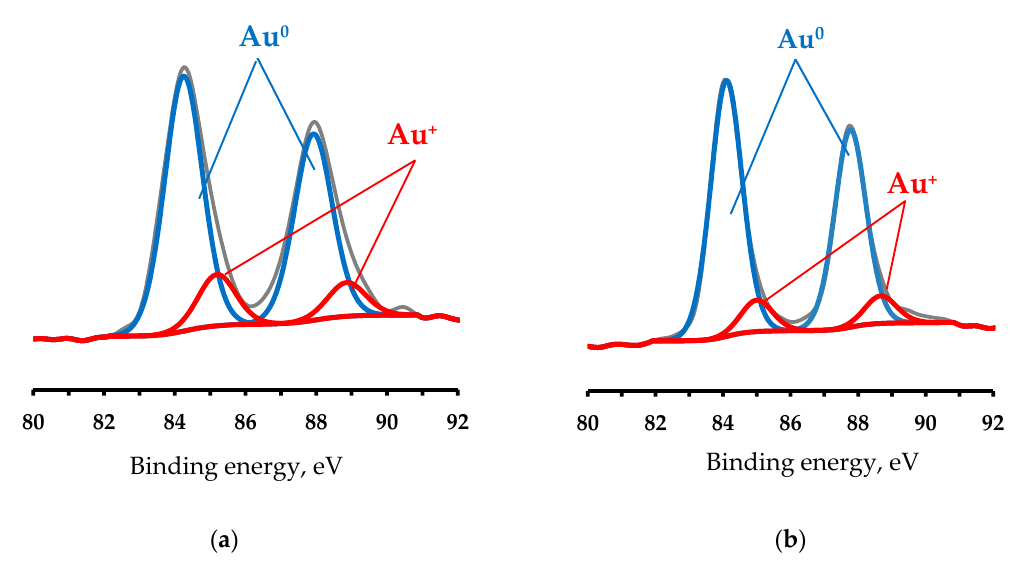
Figure 4. XPS of used 4%Au/La 2 O 3 /TiO 2 _H 2 catalyst after the 1 st ( a ) and 6 th ( b ) cycles of 1-phenylethanol peroxidative oxidation (reaction conditions as in Figure 1).